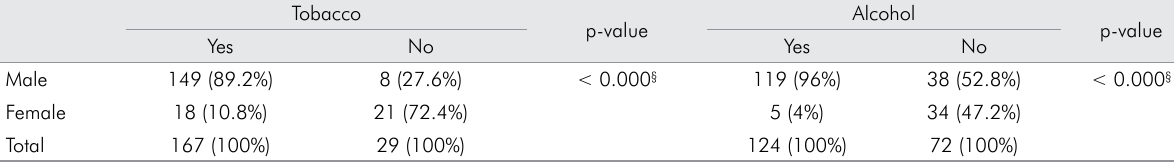
Table 2. Association between gender and use of tobacco and